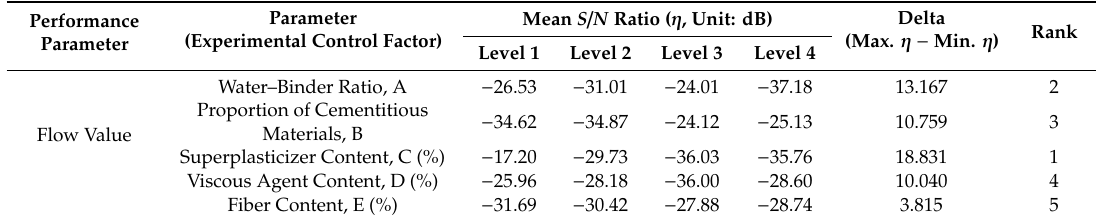
Table 10. S / N response table of